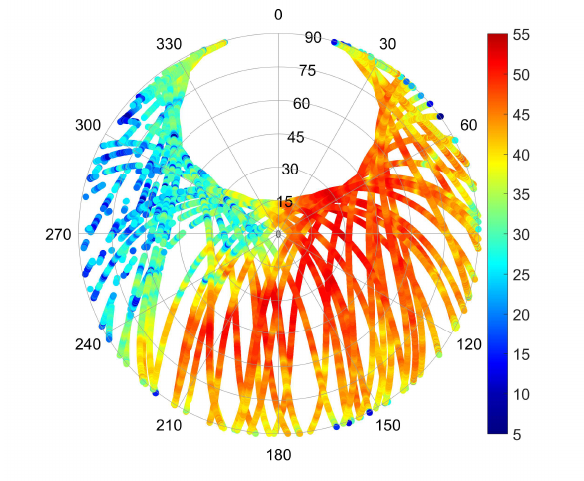
Figure 4. Sky plot of the SNR of the data collected by the East antenna on epoch